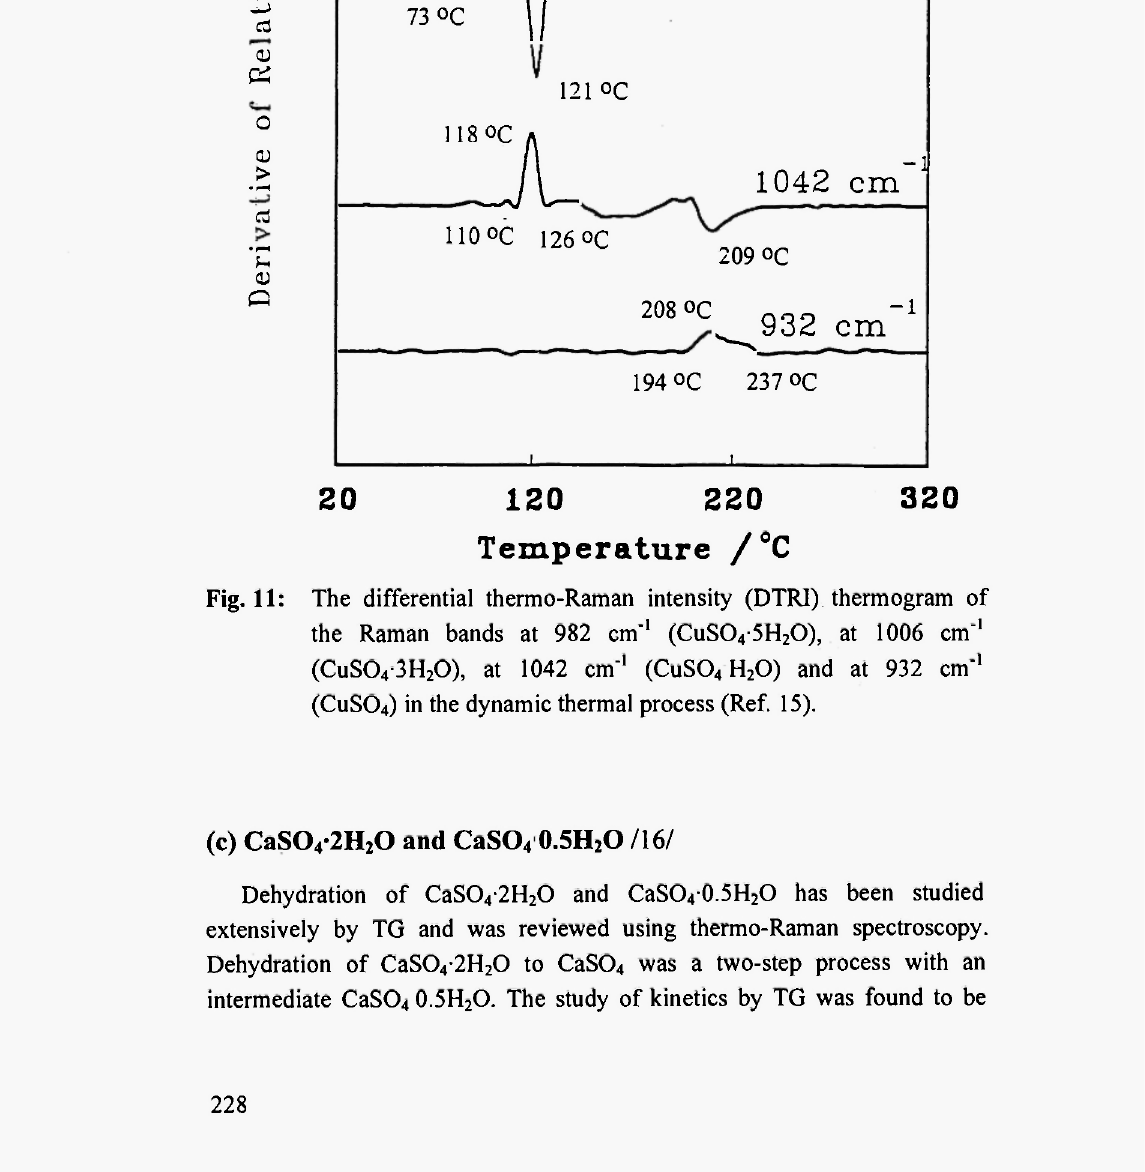
(c) CaS0 4 -2H 2 0 and C a S 0 4 0 . 5 H 2 0 /16/ Dehydration of CaS0 4 -2H 2